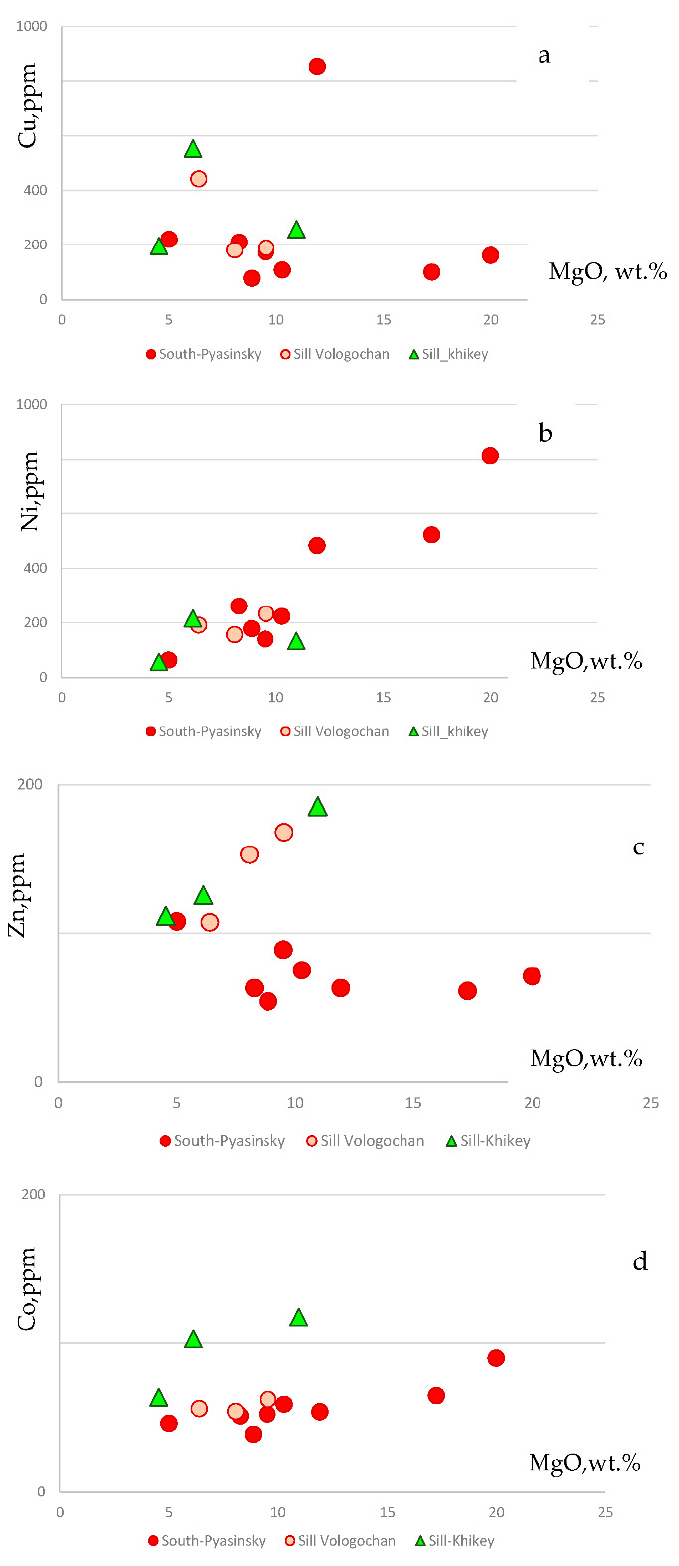
Figure 20. Diagrams MgO vs. Cu ( a ), Ni ( b ), Zn ( c ), and Co ( d ) for intrusive rocks. Captions in Figure 16.